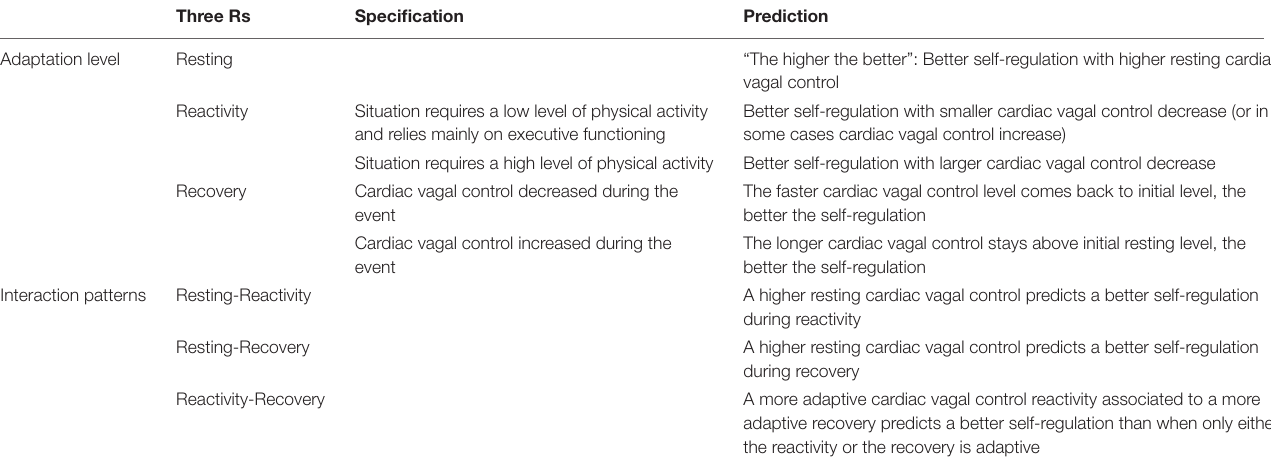
TABLE 1 | Summary of the predictions of the vagal tank theory, based on the three Rs (Resting, Reactivity,